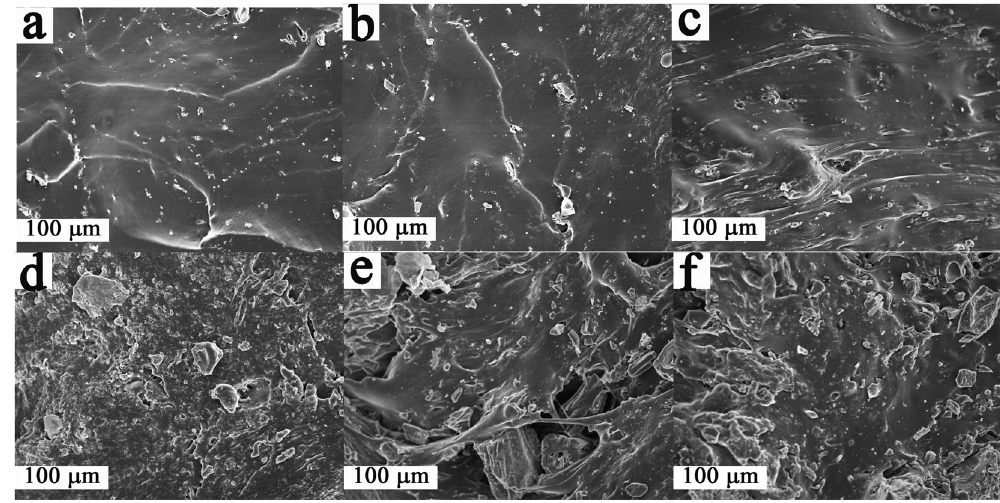
Figure 3: SEM images of NR composites with di ff erent CoFe 2 O 4 @BC loadings: ( a ) 0 phr, ( b ) 10 phr, ( c ) 20 phr, ( d ) 30 phr, ( e ) 40 phr, and ( f ) 50